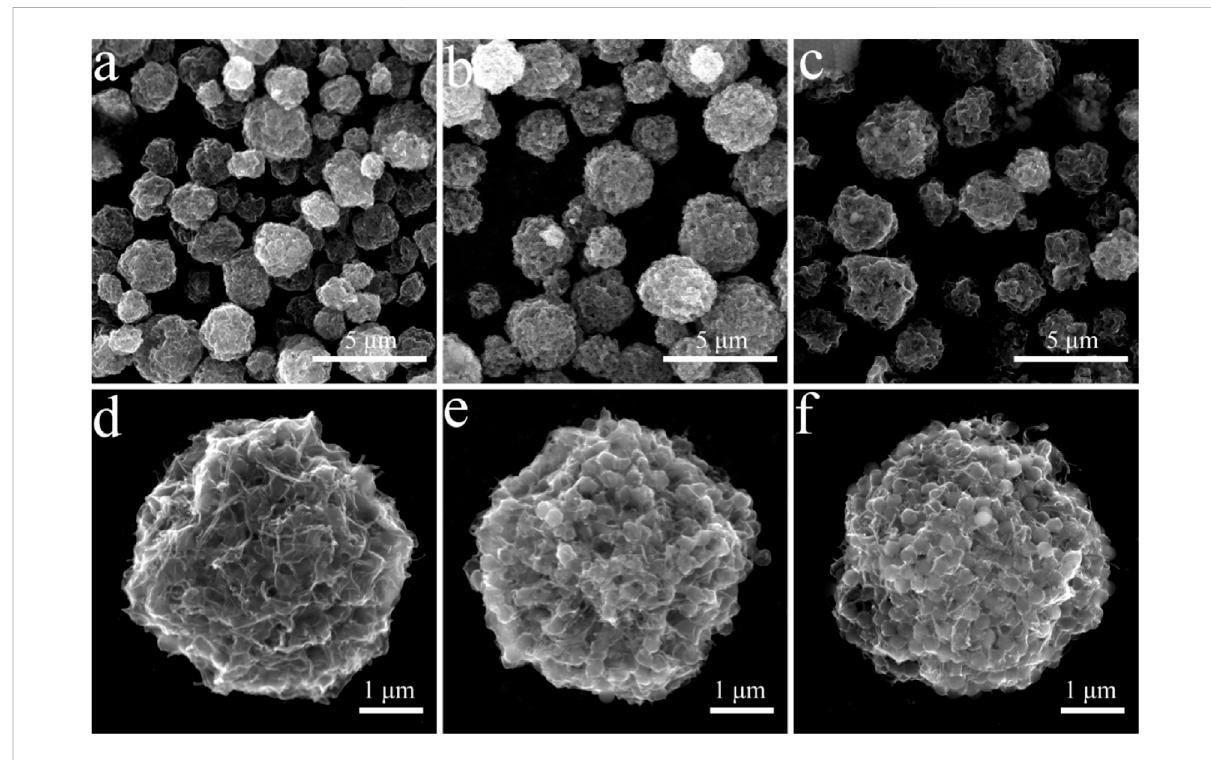
FIGURE 1 SEM images of 3D CNT/MXene@PMMA prepared with different ratios of CNT, MXene, and PMMA (A,D) 3D CNT/MXene@PMMA-8; (B,E) 3D CNT/MXene@PMMA-12; (C,F) 3D CNT/MXene@PMMA-16.